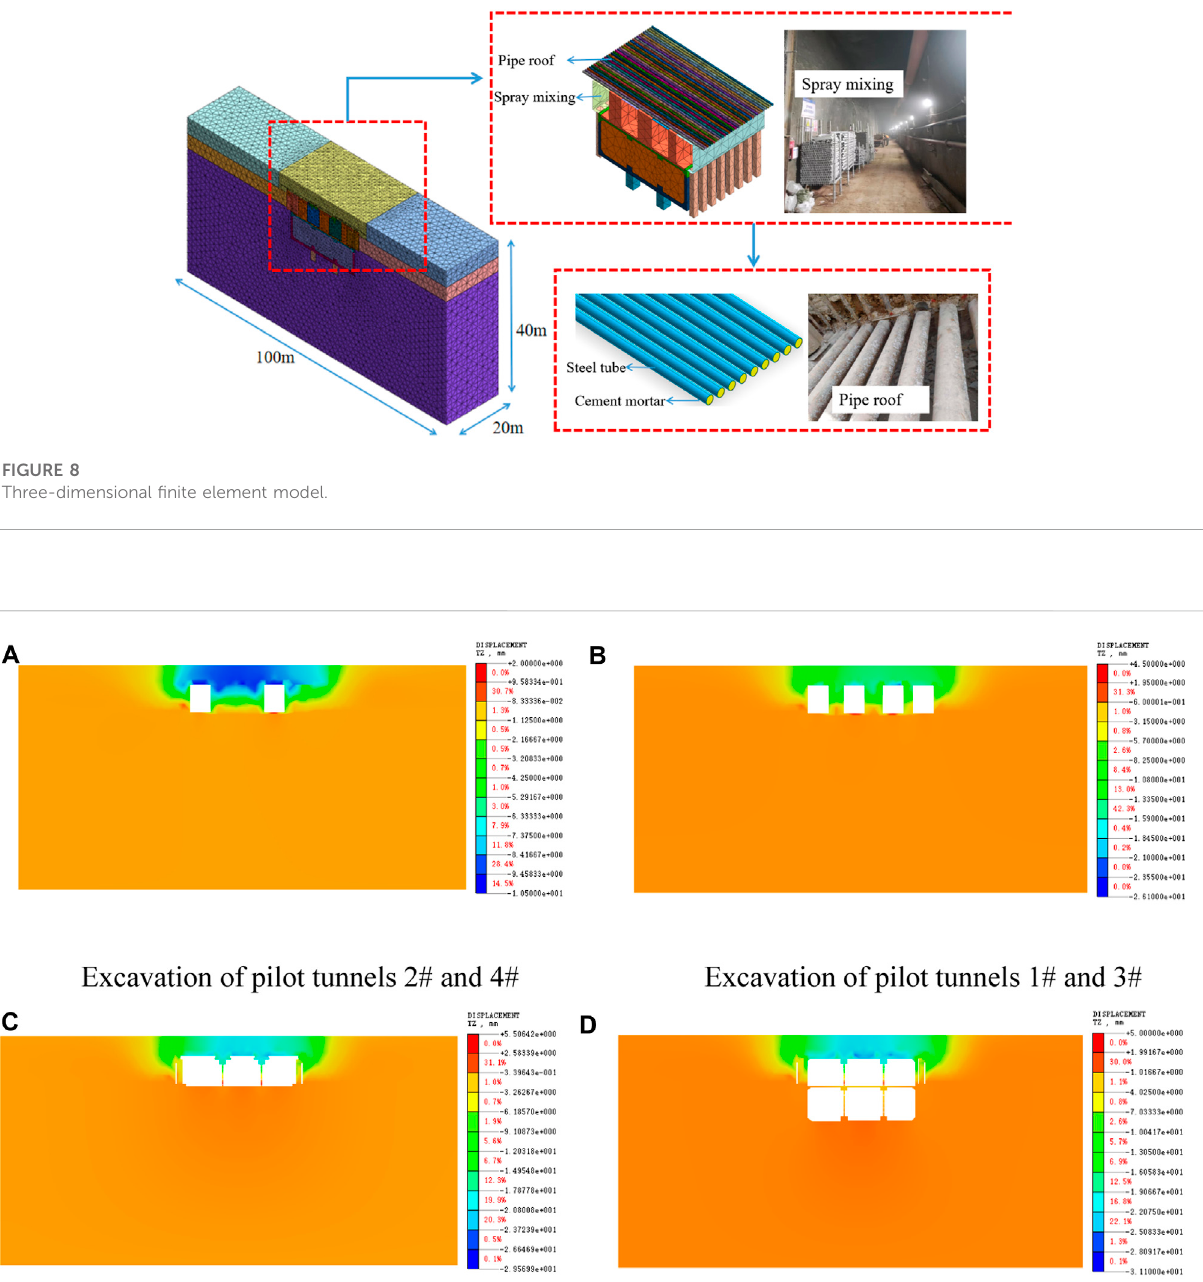
FIGURE 9 Surface subsidence cloud